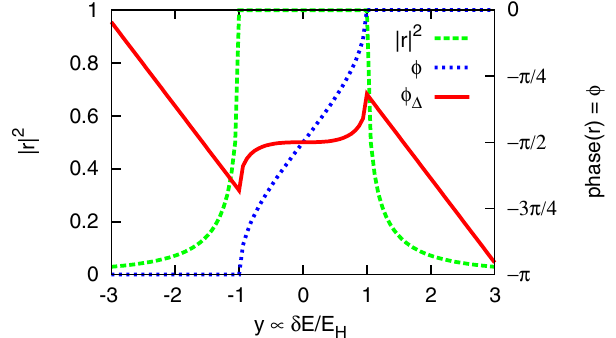
FIG. 2. Reflectivity curve for a semi-infinite, absorption-free crystal. The idealized intensity reflectivity j r j 2 is the dashed (green) line, showing the Darwin width of peak reflectivity for j y j (cid:9) 1 , and the sharp decrease outside this window. The com- plex phase of r (blue dotted line) varies such that (cid:5) (cid:5) (cid:9) (cid:7) (cid:9) 0 within this window, and the mirror acts as a dispersive element. To compensate for the linear part of the dispersion, we slightly of the decrease the cavity length, and plot the complex phase (cid:7) (cid:3) effective reflection plus cavity length reduction given in (12) as is nearly constant, the solid red line. About y ¼ 0 , the phase (cid:7) (cid:3) so that the radiation delay has been compensated and the reflected pulse is minimally